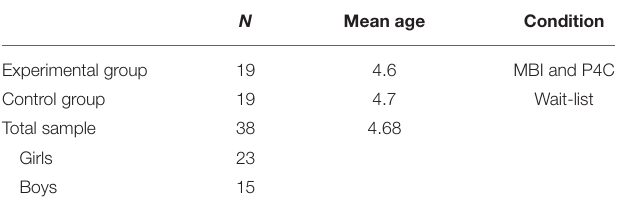
TABLE 1 | Descriptive statistics and sample distribution. TABLE 2 | Means and standard deviations for negative and positive indicators of well-being (scores on the BASC-III